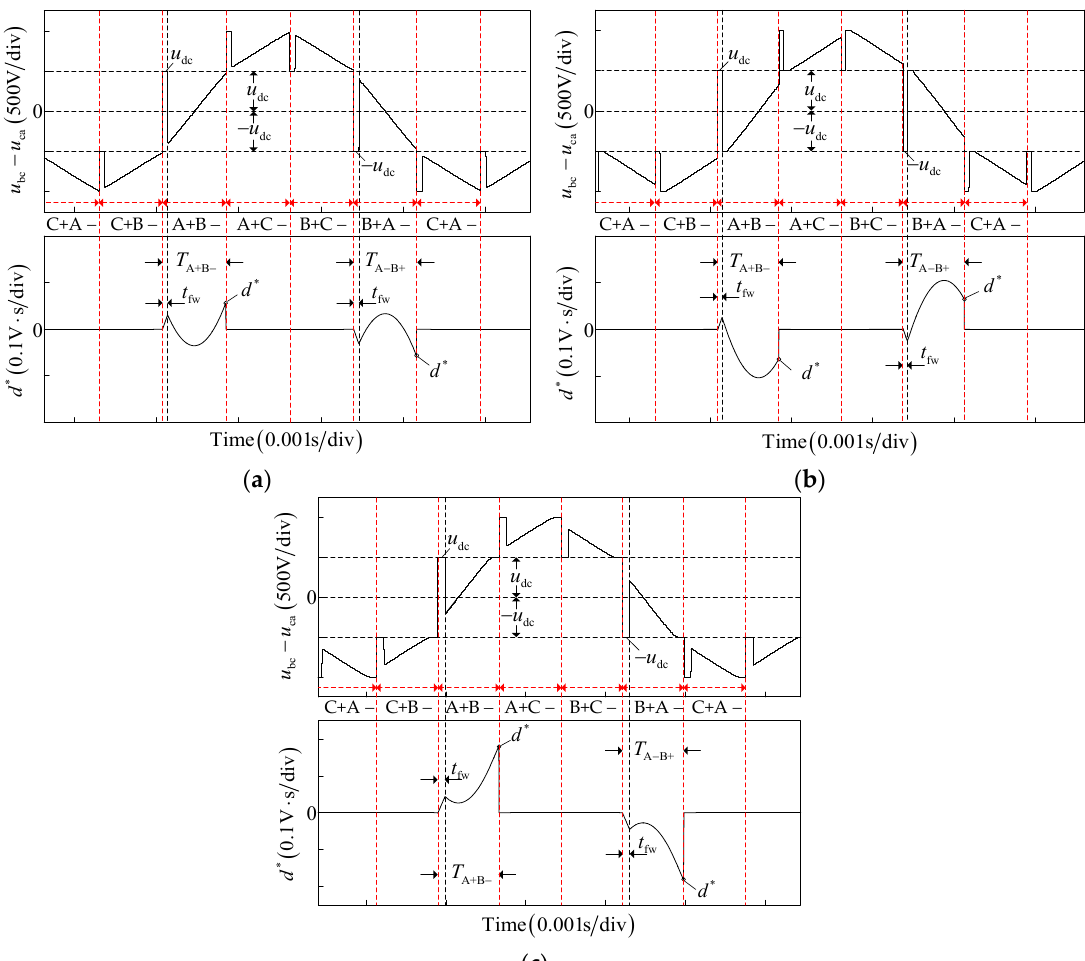
Figure 6. The line voltage difference ( u bc − u ca ) and corresponding integral d ∗ in the conduction period of phase A+B − and A − B+. ( a ) Accurate commutation; ( b ) Advanced commutation; ( c ) Delayed commutation.